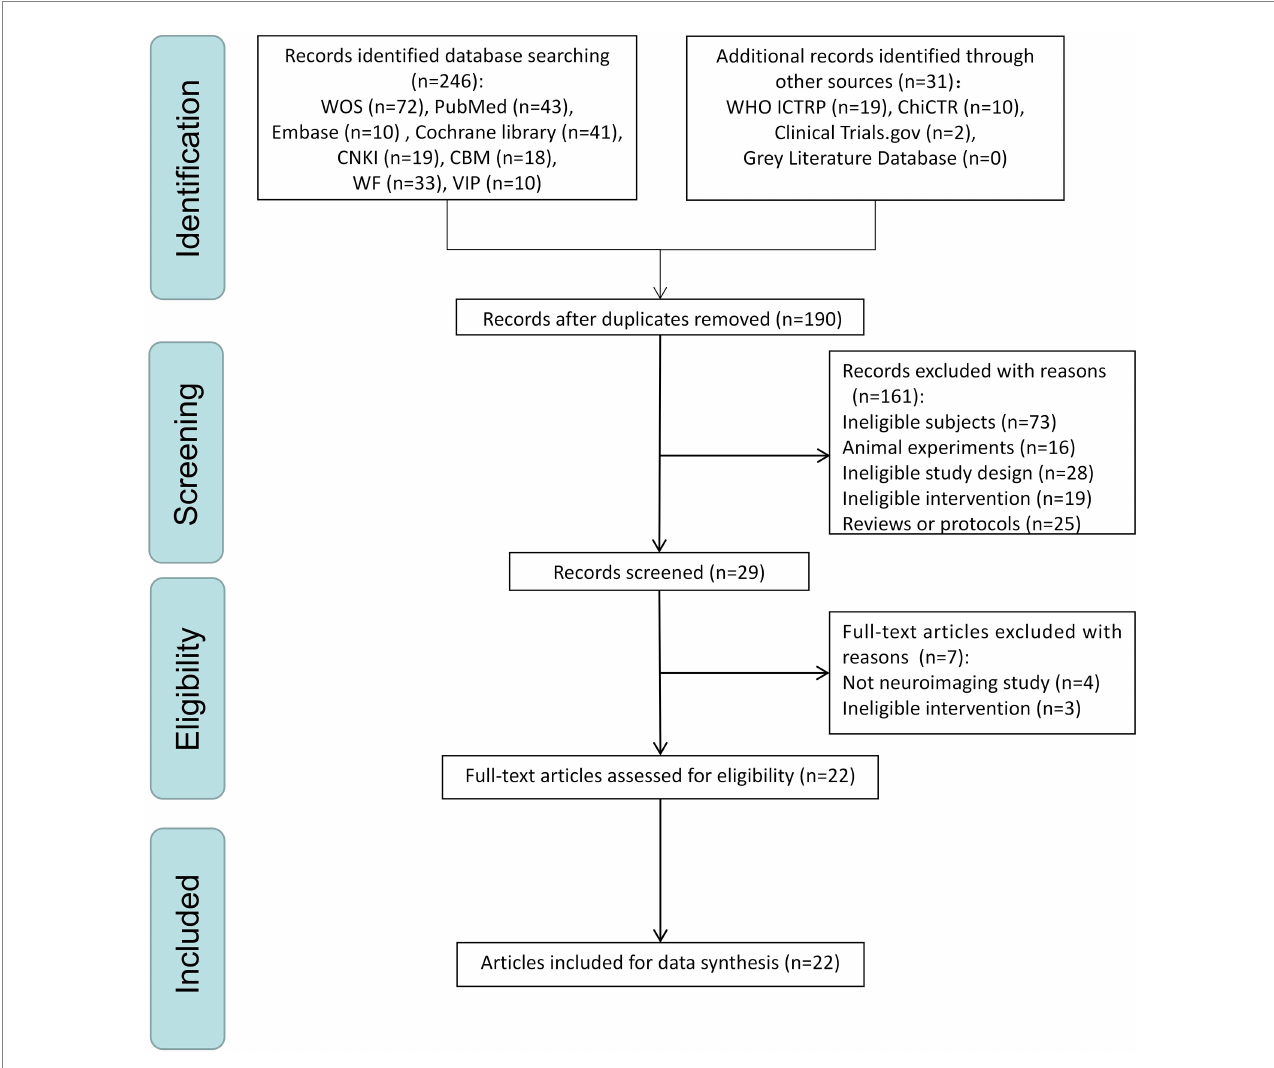
FIGURE 1 The PRISMA flow chart of selection